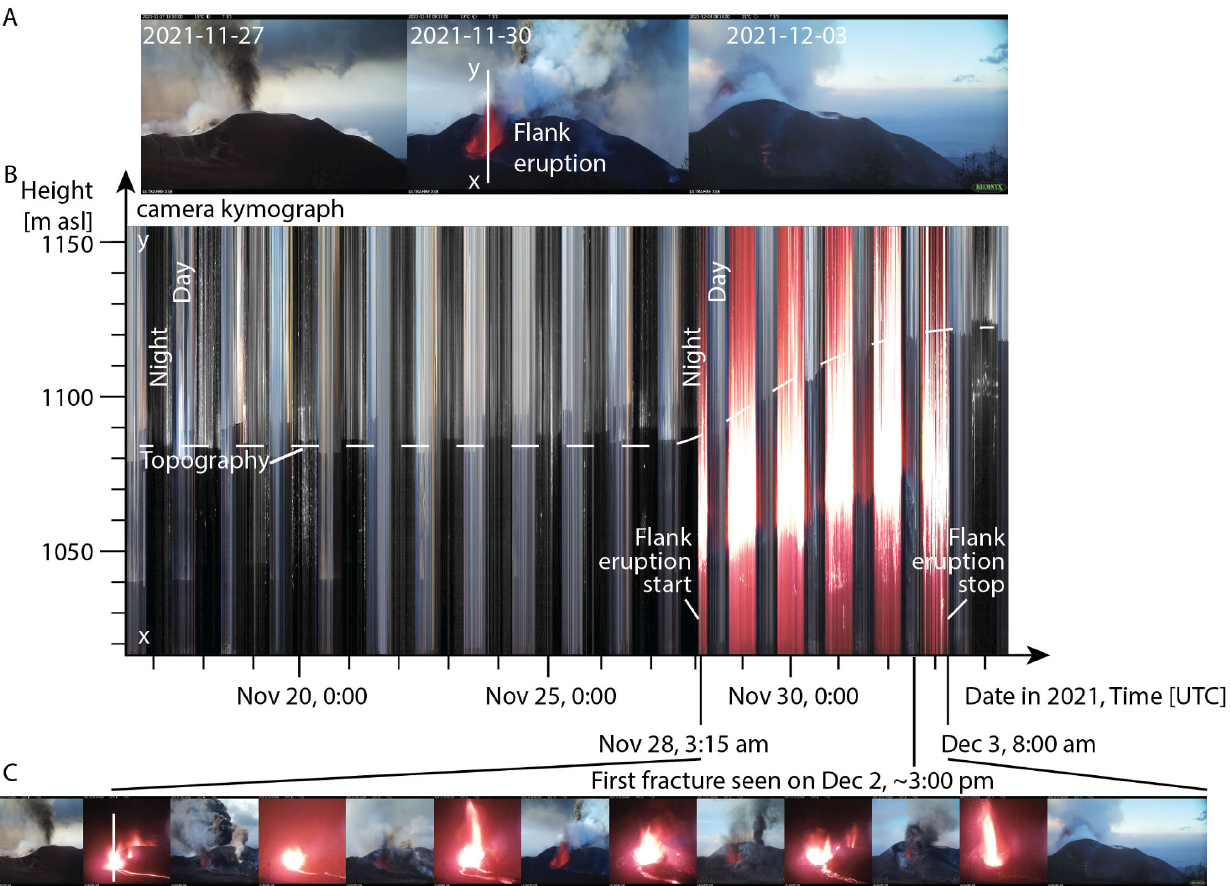
Figure 4: Camera records, realised by fixed installed time-lapse trail Cam-5. [A] Example images in November and December 2021. Note the outline shows the edifice growth. The section x-y indicates the line for the kymograph. [B] Kymograph shows night (greyscale) and day images (showing the eruption in red color). The eruption abruptly changed on 28 November 2021 to a flank eruption that abruptly stopped again on 03 December 2021. Associated with this short 6-day episode, a 40-m topography built up. The stop of this episode correlates with emergence of the lens-shaped fracture in the south. [C] Example images for the flank eruption highlights a larger number of vents at the beginning, which eventually develops into a major fountaining eruption